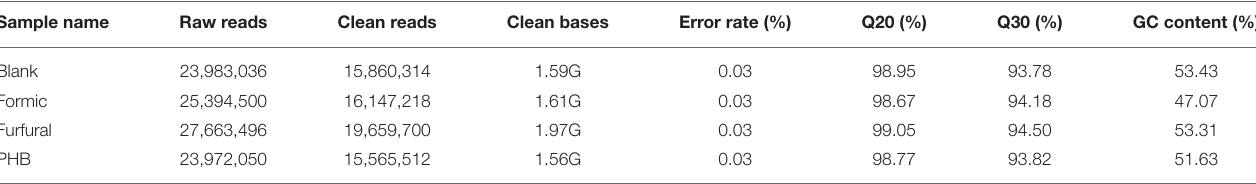
TABLE 1 | Summary of the sequence assembly.